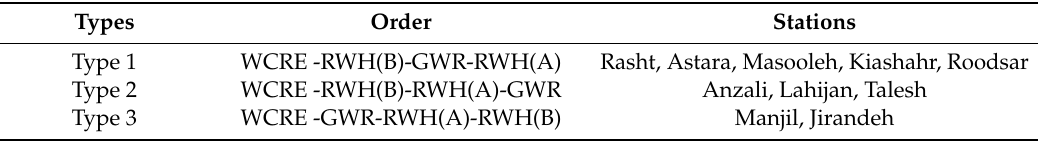
Table 4. Priorities of different water-saving schemes over the province through MCDM.